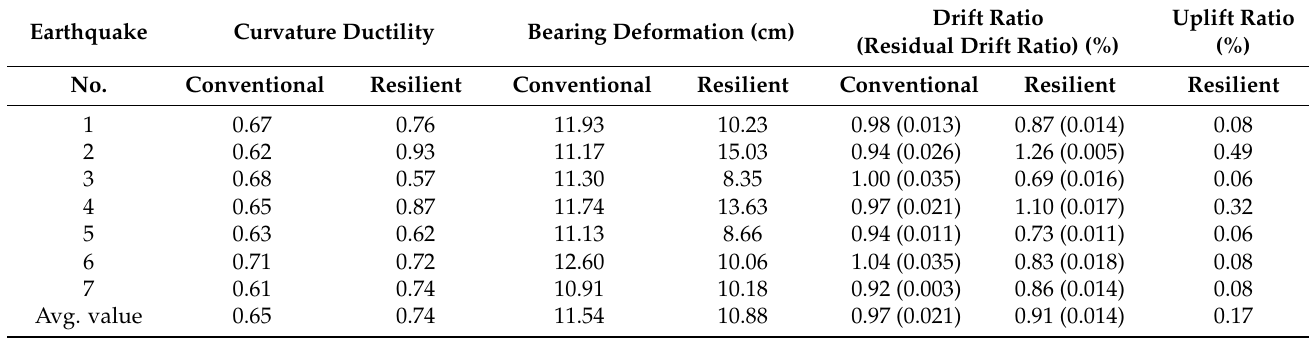
Table 3. Maximum seismic responses of ECC-reinforced bridges at E1 level.